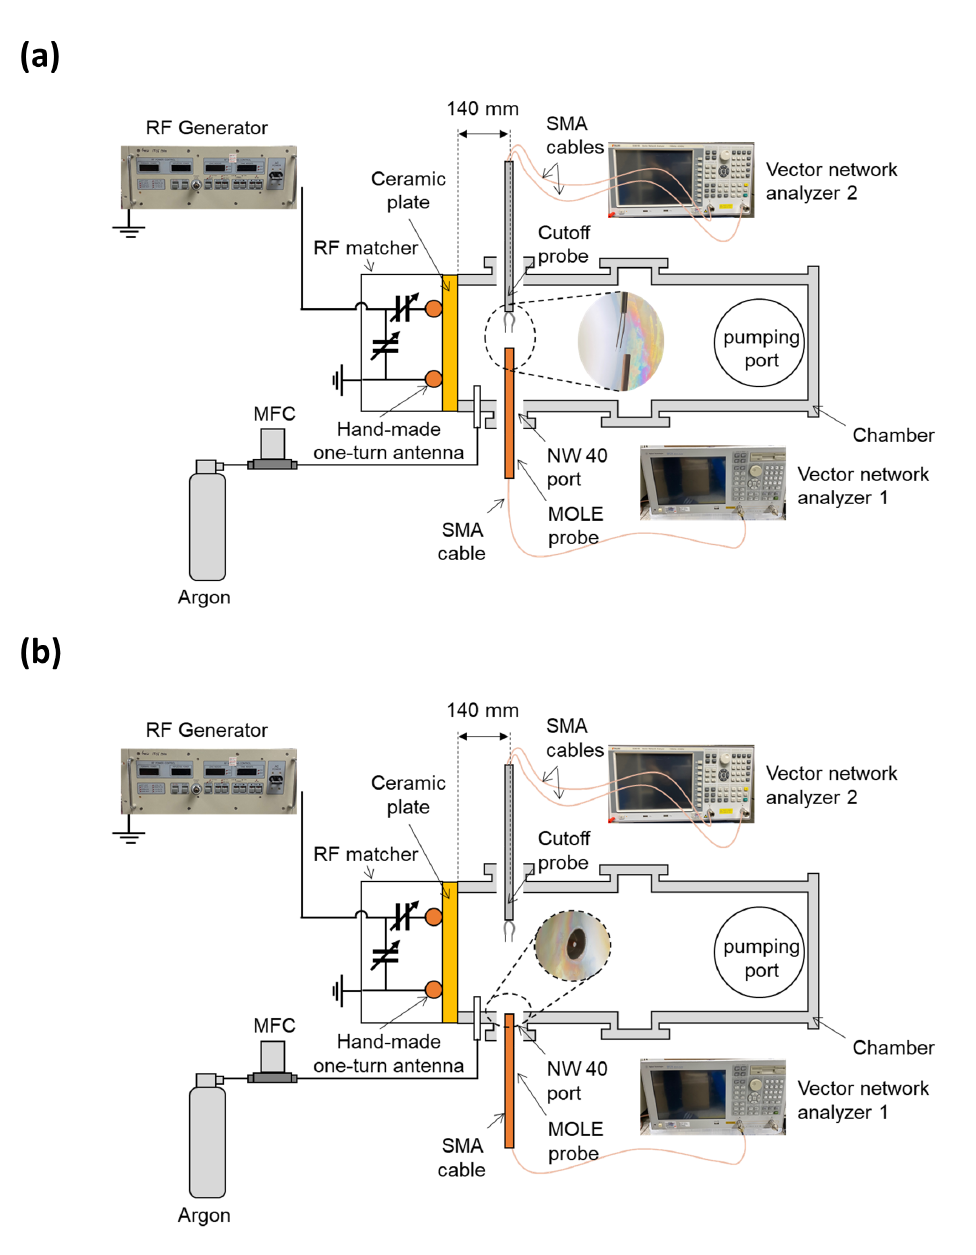
Figure 6. Schematic diagrams of the experimental setup for a demonstration of the MOLE probe positioned ( a ) in the center of the chamber and ( b ) on the chamber